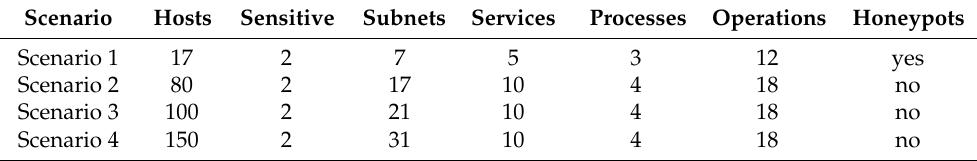
Table 3. Experimental network scenarios list.